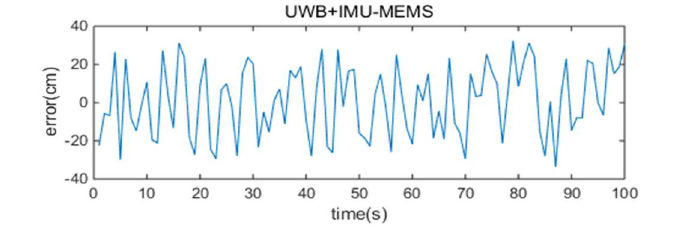
Figure 7. Indoor experimental tests by UWB + IMU method.